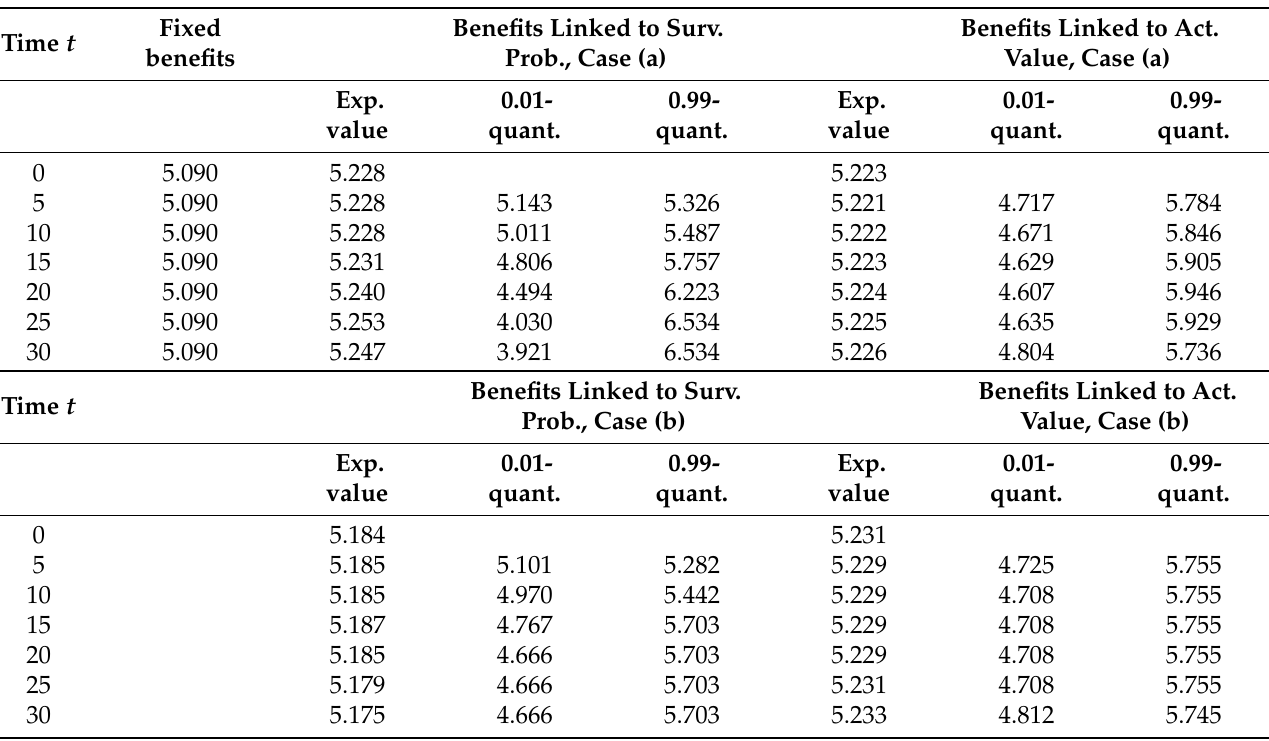
Table 3. Benefit amount b t (expected value and 0.01- and 0.99-quantiles) for selected times. Major aggregate